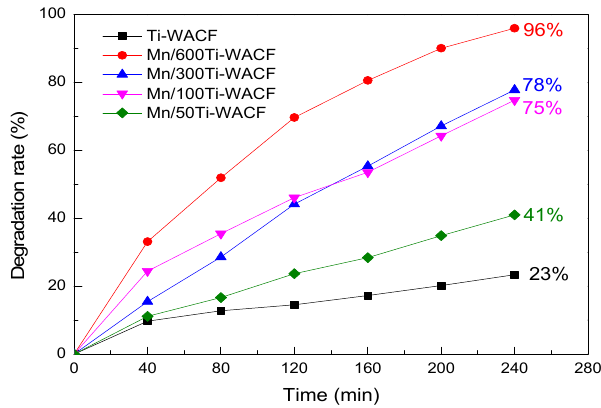
Figure 7. Degradation curve chart of methylene blue by samples with different Mn-doping concentrations under visible lights.